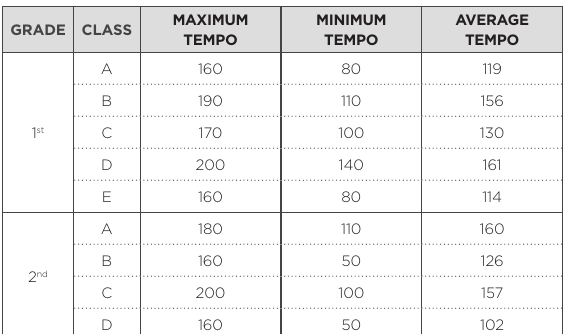
TABLE 8 | Average tempo in scales performance per